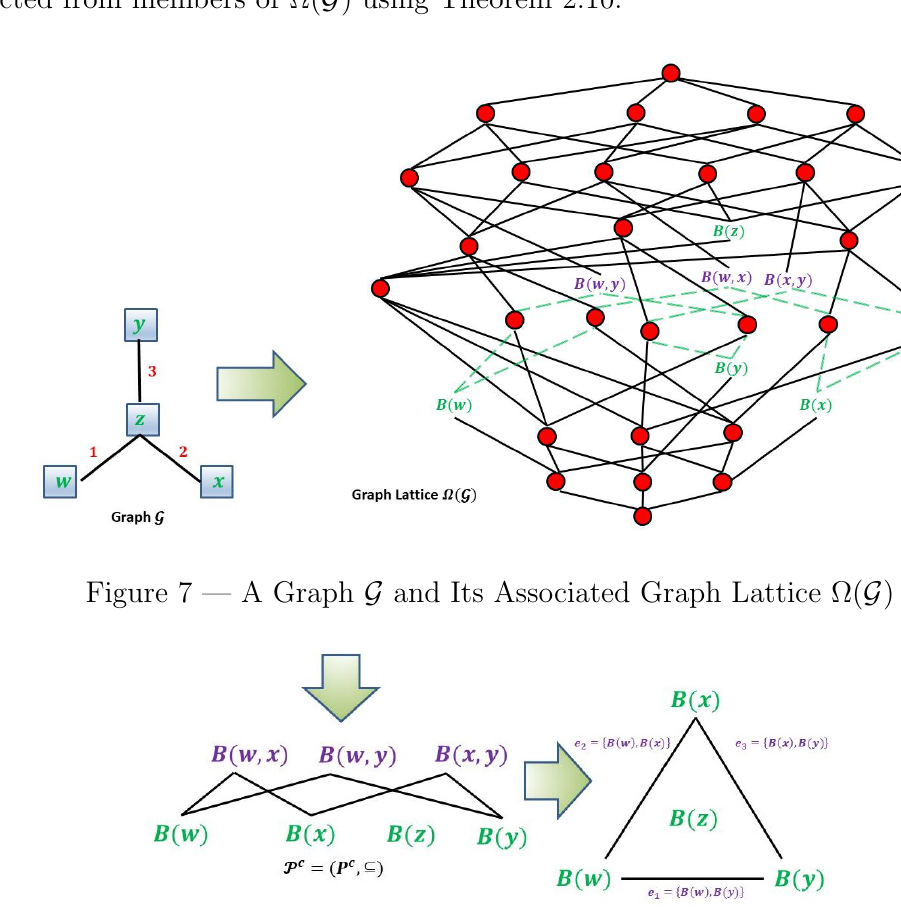
Figure 8 — Using a Subposet of Ω( G ) to Construct the Graph Compelement of